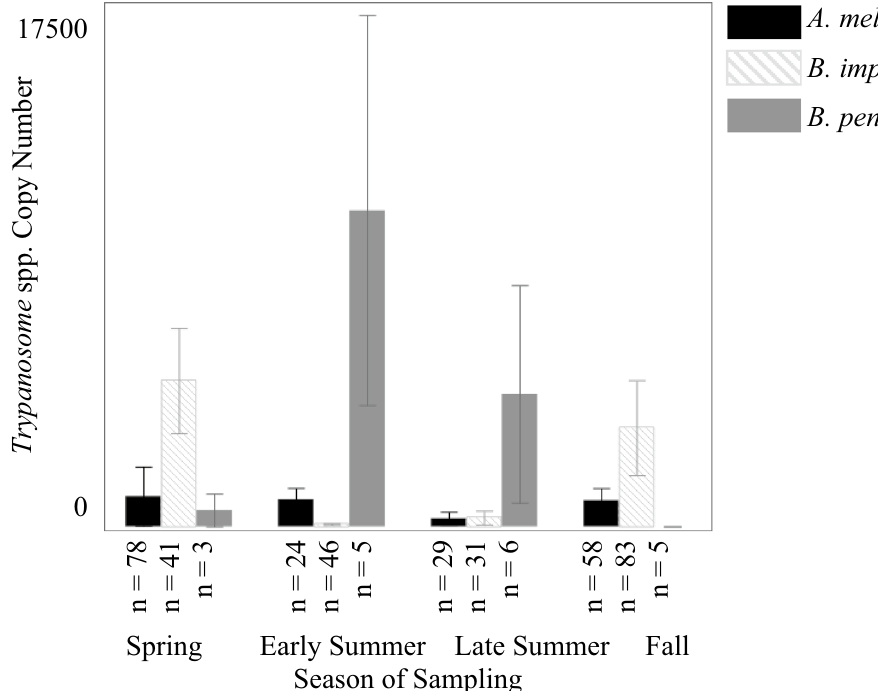
Figure 3. Copy number per 1 µl of template (approximately 3.3 ng of RNA) of Trypanosome spp. for A. mellifera, B. impatiens, and B. pensylvanicus across the sampling